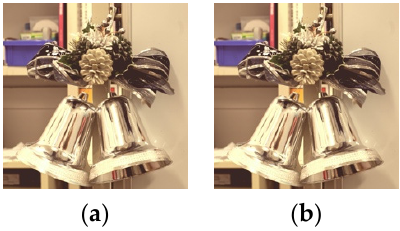
Figure 9. Images with gamma function applied (Xperia1). ( a ) threshold :0.9 parameter: 1.5; ( b ) threshold: 0.8 parameter: 0.5.